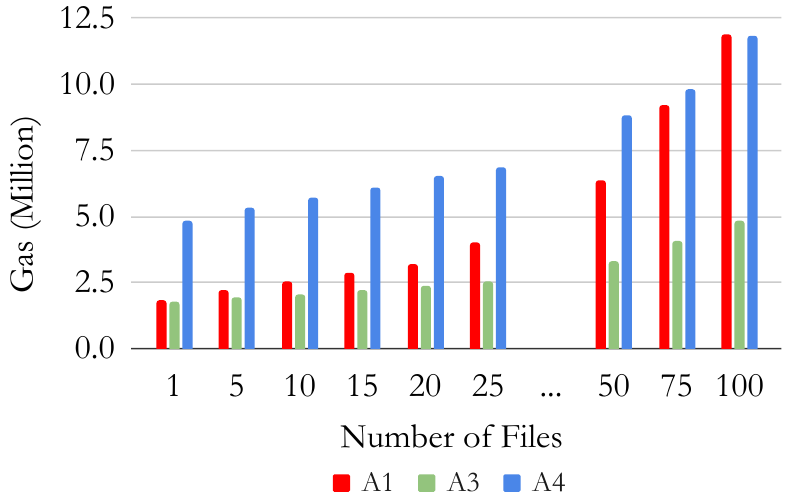
Figure 15. Total gas usage for creating and searching different number of files for Architectures 1, 3, and 4. Table 6. Gas usage compared to state of the art with different number of